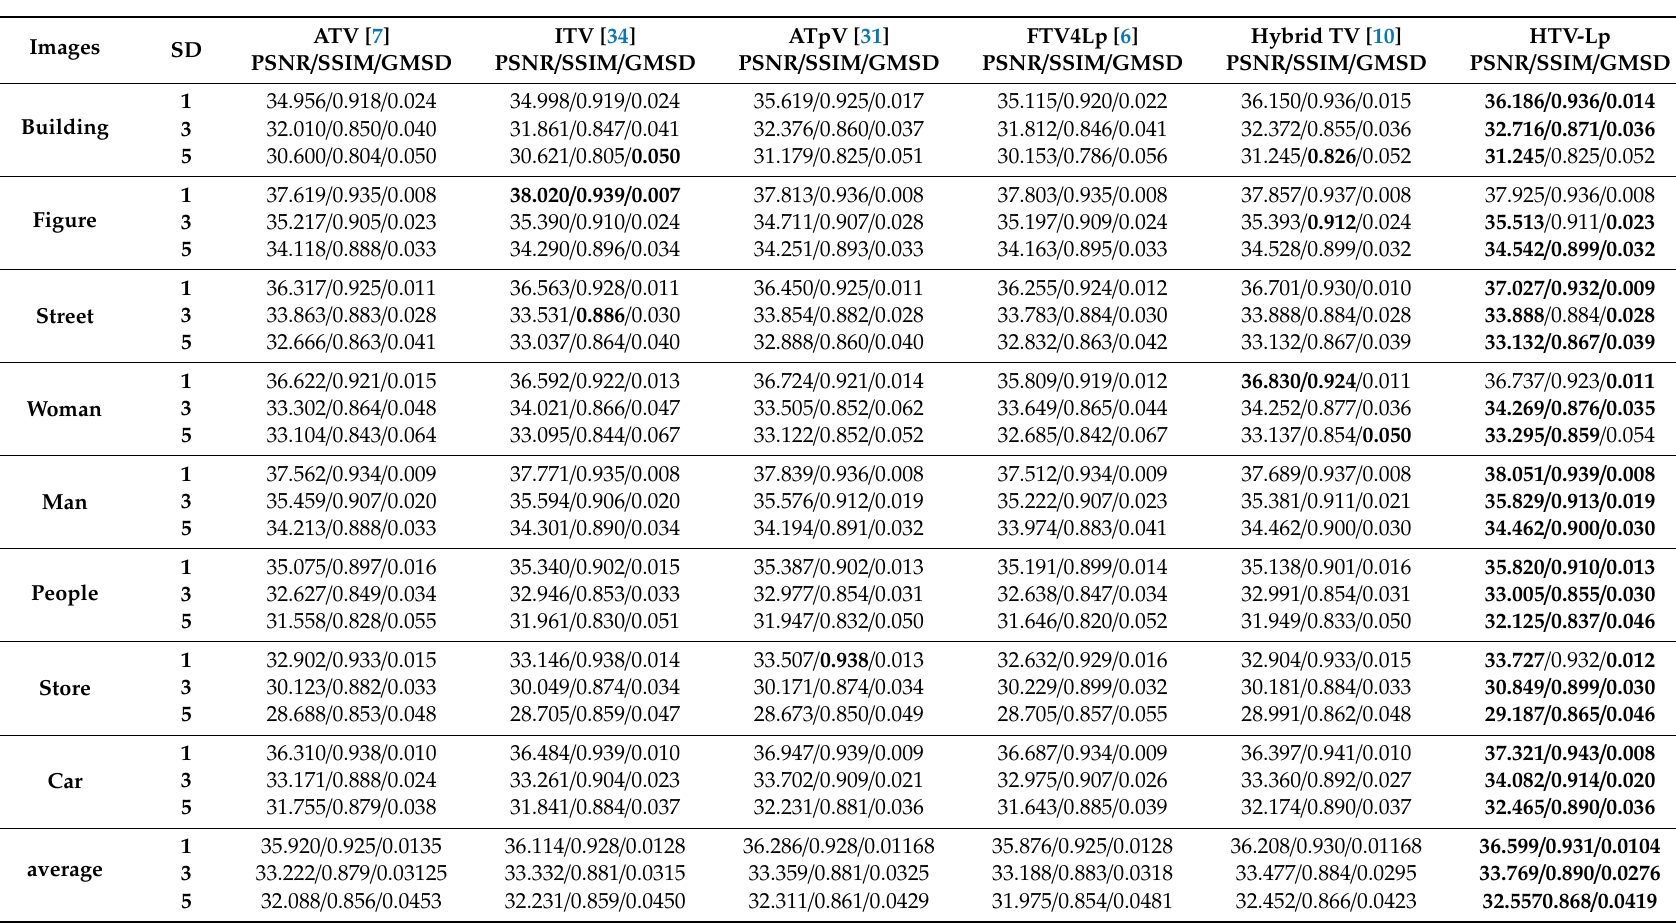
Table 3. Evaluation metrics of the six algorithms for various images with Gaussian blur (G, 5, 5, 7) with a Gaussian noise standard deviation (SD) of 1, 3, and 5.